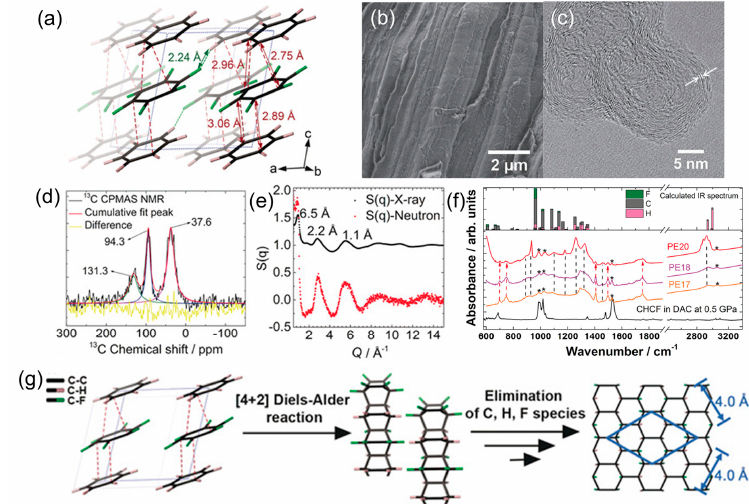
Figure 9. ( a ) The crystal structure of C 6 D 6 -C 6 F 6 before reaction (20 GPa) [109]. ( b ) Scanning electron microscope (SEM) images, ( c ) transmission electron microscope (TEM) images, ( d ) 13 C cross-polarization magic-angle-spinning solid state NMR (CPMAS ssNMR) spectrum and ( e ) the synchrotron X-ray with neutron PDF data of C 6 H 6 -C 6 F 6 recovered from 20 GPa [109]. ( f ) IR absorption spectrum of starting material (black), C 6 H 6 -C 6 F 6 cocrystal recovered from 17 GPa (orange), 18 GPa (purple), 20 GPa (red), and the calculated IR spectrum of the H-F graphane model [109]. ( g ) The proposed reaction route from C 6 H 6 -C 6 F 6 cocrystal to H, F-graphane [109].